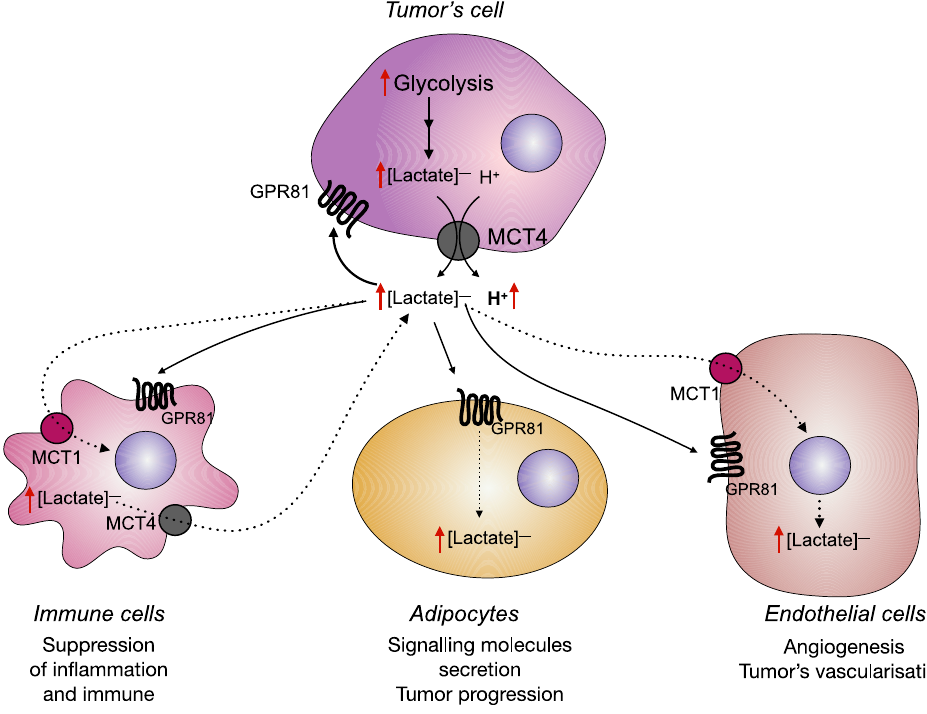
Figure 2. Lactate signaling function in the malignant transformation process. The intensification of glycolysis in tumor cells leads to high lactate production; lactate anions along with protons are cotransported through MCT4 transporters in the extracellular medium that provides acidification of the tumor microenvironment and high extracellular lactate concentration. By binding to GPR81 receptors on different cell types, lactate promotes the expression of pro-oncogenic genes, immune suppression, angiogenesis, tumor cell proliferation, and some other effects.